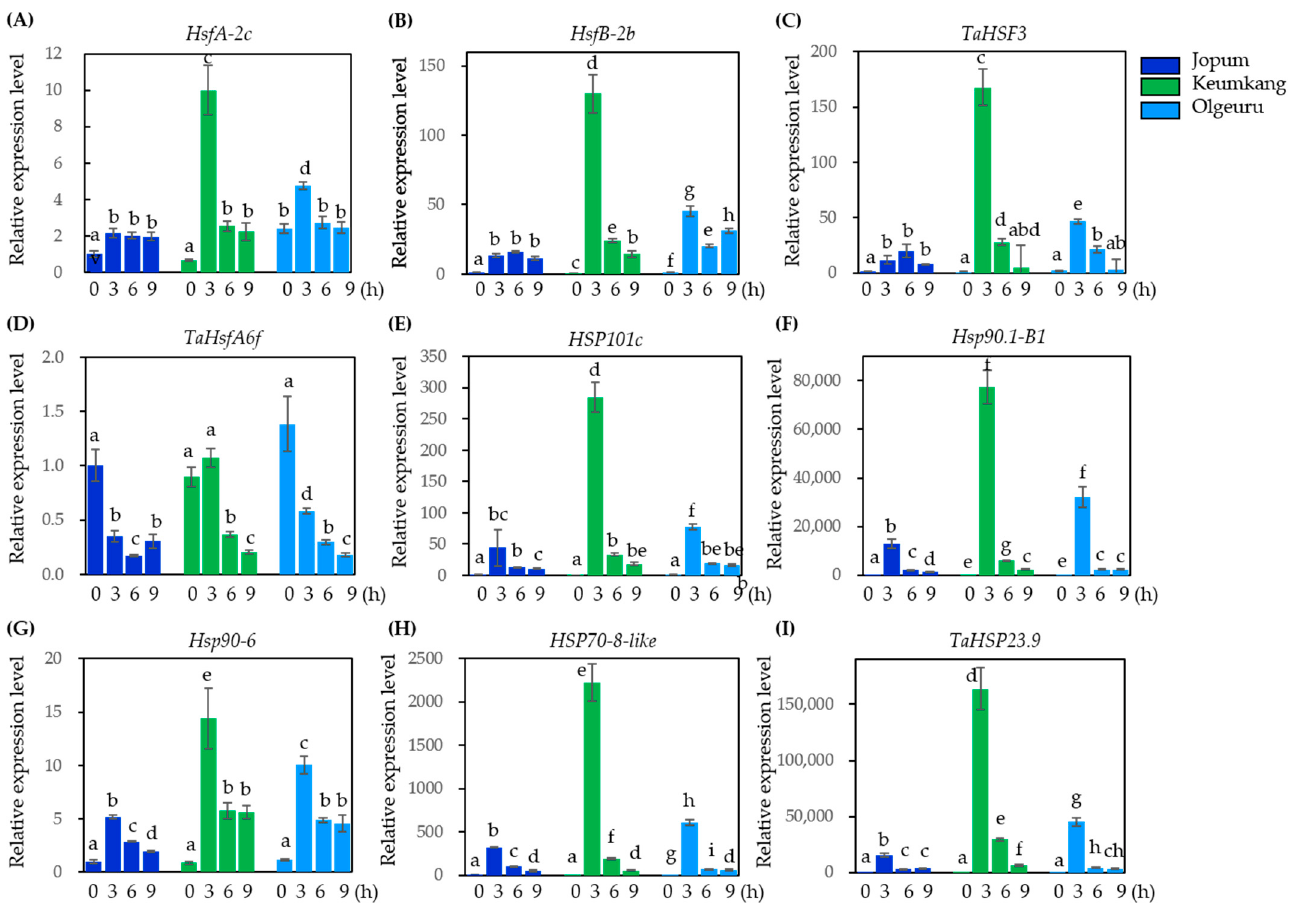
Figure 8. qRT-PCR expression analysis of selected heat shock protein (HSP) and heat-stress transcription factor (HSF) genes in response heat stress in three varieties in RNA-seq data. Relative expression level of HSFs TraesCS1A02G375600 (HsfA-2c) ( A ), TraesCS7A02G270100.1 ( HsfB-2b ) ( B ), TaHSF3 ( C ), TaHsfA6f ( D ), HSFs HSP101 TraesCS3D02G273600.1 ( E ), HSP90.1B1 TraeCS2B02G474001.1 ( F ), HSP90.6, TraesCS5D02G113700.1 ( G ), HSP70-8 TraesCS4A02G066100.1 ( H ), and TaHSP23.9 ( I ) in wheat leaves after heat treatment at 35 °C during 3, 6, and 9 h. Data are representative of results from three independent experiments. Error bars represent SD ( n = 3). Different letters on the bars indicate significant differences between treatments (ANOVA followed by Tukey’s test, p < 0.05). HSP, heat shock protein; HSF, heat stress transcription factor.